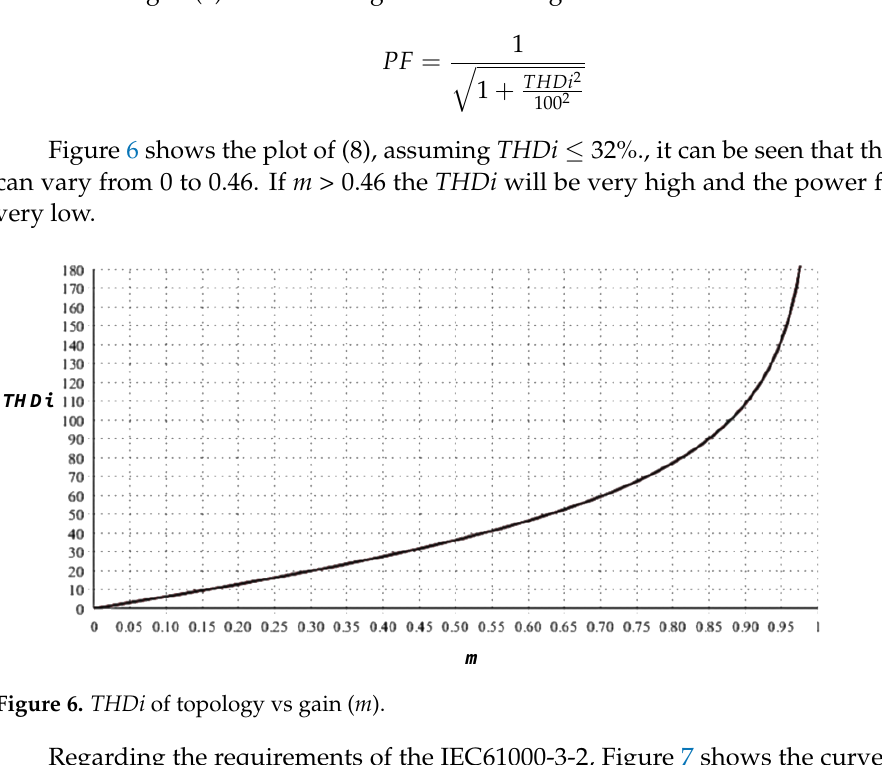
% m n=3 n=5 n=7 n=9 n=11 Figure 7. Curves of each harmonic of the topology vs the gain ( m ). PF m Figure 8. PF of the topology vs the gain ( m ).